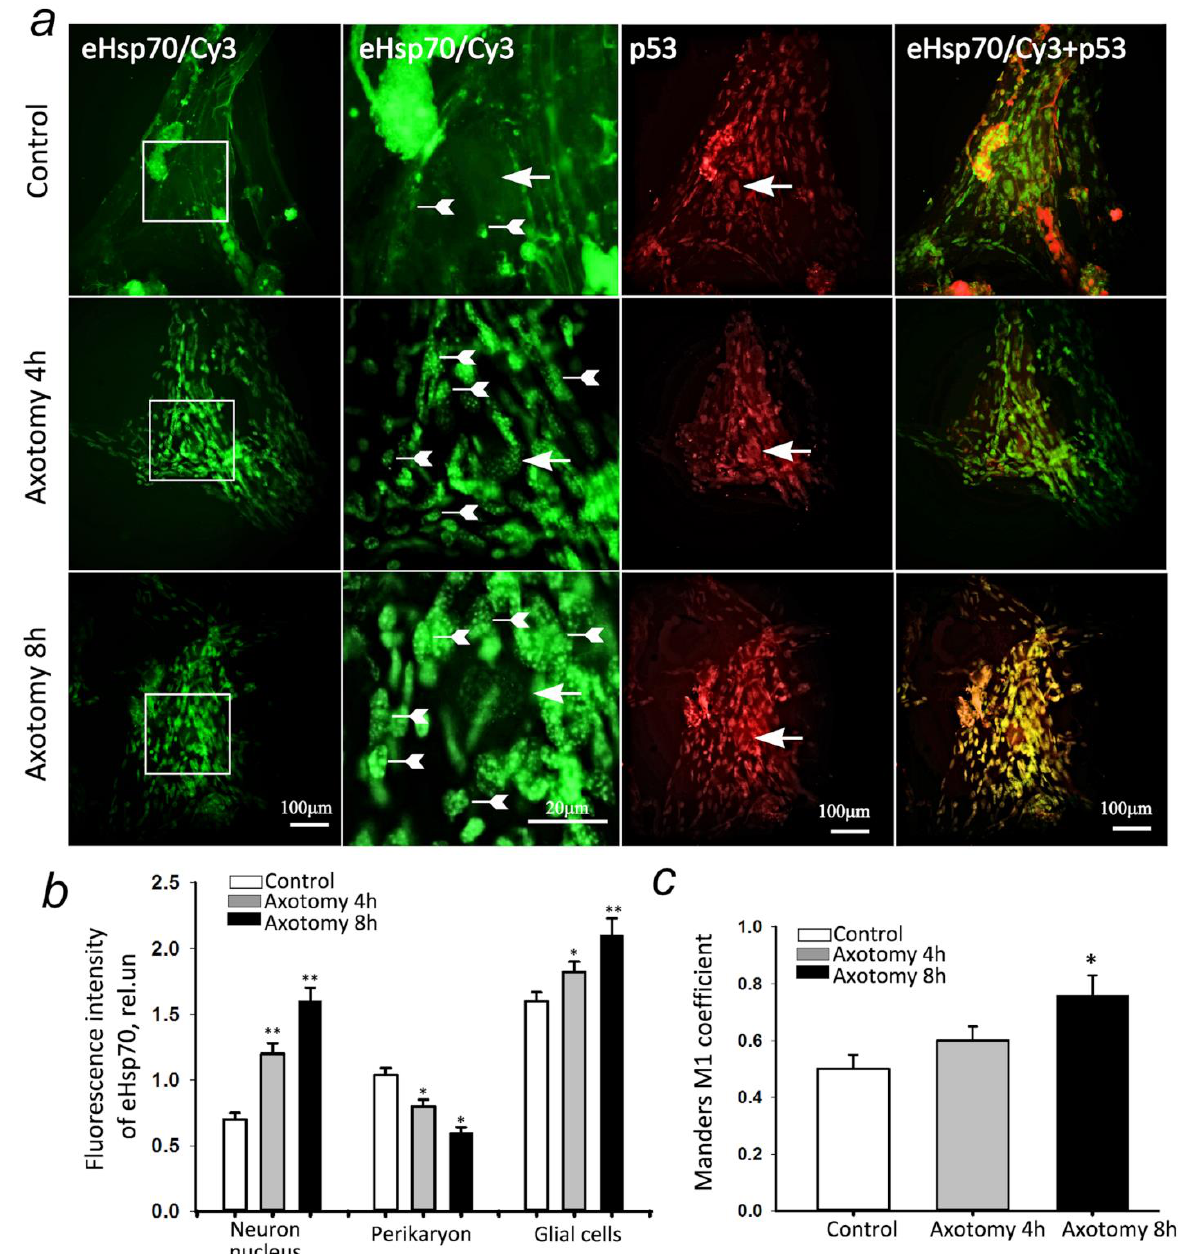
Figure 6. Cellular and intracellular distribution of eHsp labeled with the fluorescent dye Cy3 and its co-localization with the p53 protein. ( a ) Typical images of eHsp fluorescence-labeled with the fluorescent dye Cy3 (eHsp/Cy3, green) and immunofluorescence of the p53 protein (red), as well as their merged images. The crayfish mechanoreceptor neuron is one large neuron with a large nucleus (the arrows indicate nuclei of neurons), surrounded by smaller glial cells (the arrow tails indicate glial cells). Scale bar, 100 µm. ( b ) The intensity of eHsp/Cy3 fluorescence in the nuclei and perikaryon of neurons and glial cells in normal conditions and 4 and 8 h after axotomy. ( c ) Changes in the Manders’ coefficient M1, showing the degree of co-localization of Hsp70/Cy3 with the p53 protein. N = 10. * p < 0.05; ** p < 0.01 compared to the control group.